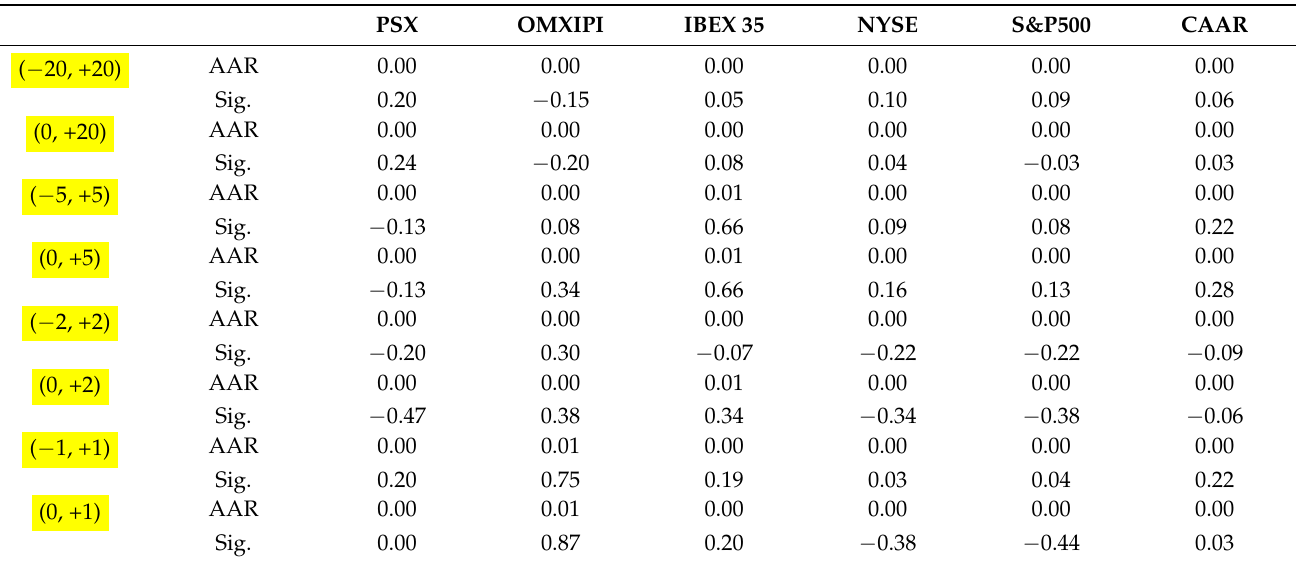
Table A30. Average abnormal returns and cumulative average abnormal returns (Jurgen Mossack Resignation).